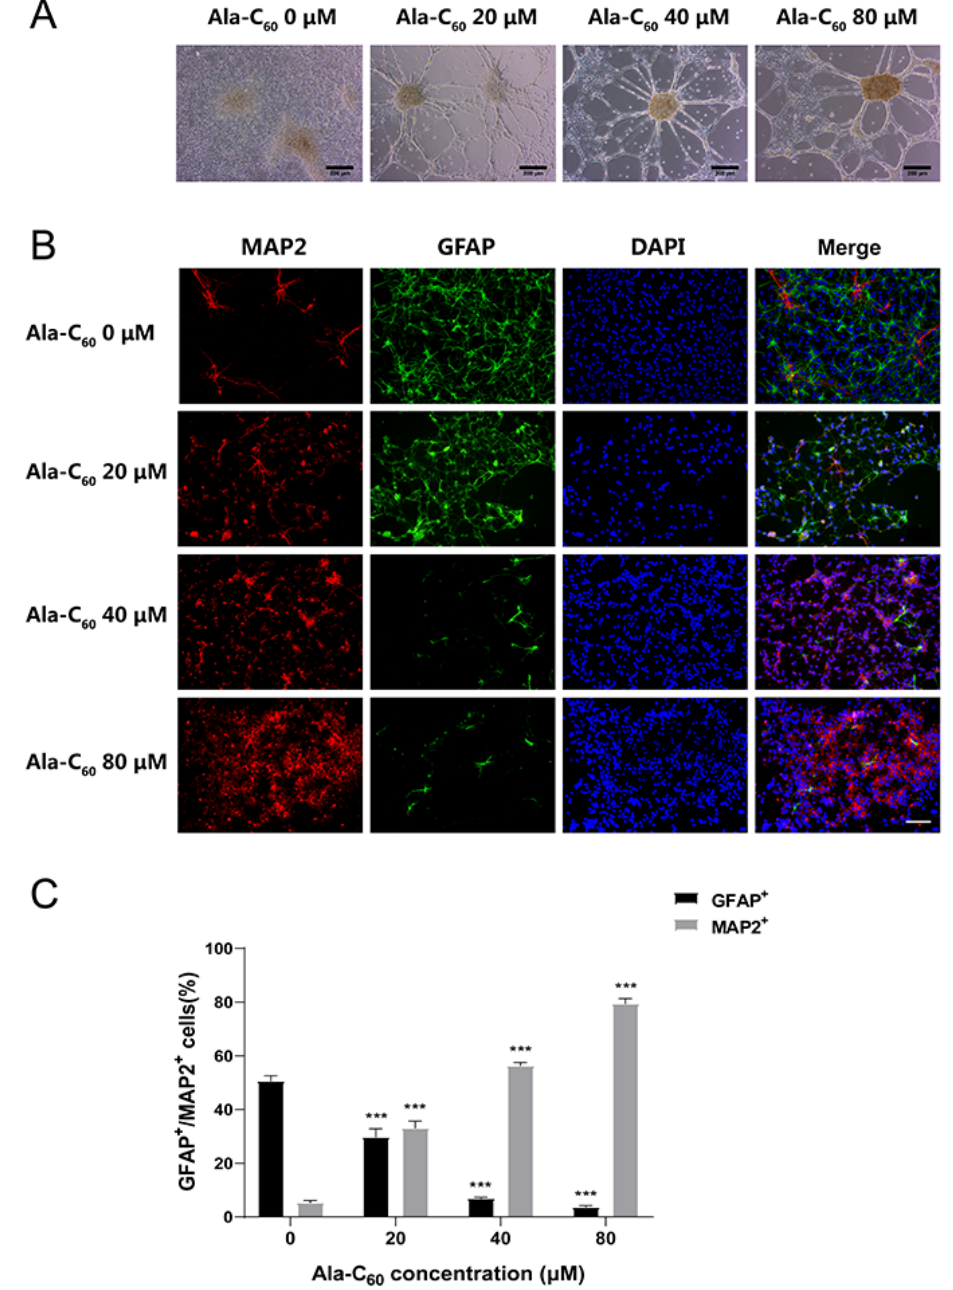
Figure 4. The effect of Ala-C 60 on the differentiation of cultured NSCs. ( A ) Optical microscopy Figure 4. The e ff ect of Ala − C 60 on the differentiation of cultured NSCs. ( A ) Optical microscopy im ‐ images of nerve cells on the seventh day of differentiation. Scale bar = 200 µ m. ( B ) MAP2 (red)/GFAP ages of nerve cells on the seventh day of differentiation. Scale bar = 200 µm. ( B ) MAP2 (red)/GFAP (green)-positive cells were identified via immunohistochemical staining. DAPI (blue) was used (green) − positive cells were identi fi ed via immunohistochemical staining. DAPI (blue) was used to to label the nuclei. Scale bar = 100 µ m. ( C ) Quantitative analysis of MAP2/GFAP-positive cells. label the nuclei. Scale bar = 100 µm. ( C ) Quantitative analysis of MAP2/GFAP − positive cells. *** p < *** p < 0.001 according to ANOVA followed by LSD post hoc 0.001 according to ANOVA followed by LSD post hoc analysis.